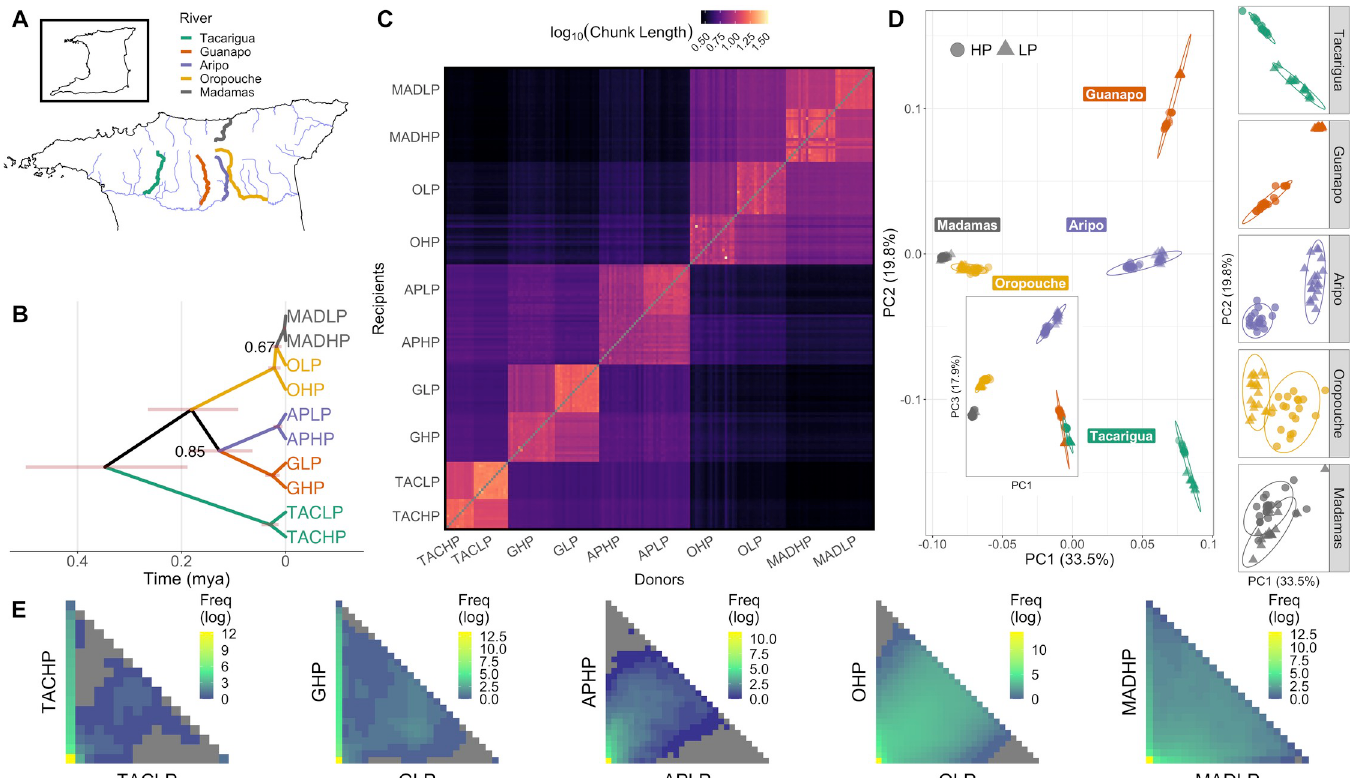
Fig 1. Sampling sites, population structure and admixture across the five rivers. Map (A) highlights sampled rivers from the three drainages in Northern Trinidad. Other major rivers are illustrated in light blue. Sampling rivers plotted alongside topography is available in S3 Fig. The coastline shapefile was sourced from OpenStreetMap (openstreetmap.org; CC BY-SA 2.0), rivers were added manually and are available as shapefiles at Zenodo doi: 10.5281/zenodo.4740381. The dated phylogeny (B) of sampling populations based on SNAPP, highlighting sister statuses of each HP-LP pair. Red regions around nodes denote 95% uncertainty around dates. Nodes with < 90% support are indicated with their posterior support. Heatmap (C) illustrates the length of painted recipient haplotypes based on donor haplotypes, used by fineSTRUCTURE to infer coancestry (values are log10-transformed). PCA (D) with populations coloured according to river and shaped according to predation regime. PC1 and PC3 are presented in the insert. In the main panel, ellipses denote river clusters at 95% confidence intervals. The right-hand column shows zoomed-in regions around each river cluster on PC1 and PC2, with ellipses highlighting separation and 95% confidence intervals of predation clusters. Heat maps in (E) show projected two- dimensional site frequency spectra (2dsfs) for each river pair highlighting the sharing of variants between LP and HP populations within each river. LP populations are on the x-axis and HP populations are on the y-axis. In each sfs, the frequency of sites in each population is illustrated from 0 to 2 N, where N is the number of individuals in each population. Each cell within these 2dsfs therefore shows the density (log-transformed) of SNPs with relevant allele counts in each population. Cells within the first column and first row show private alleles that are absent in one population (allele count of 0). Grey cells are missing data, where no SNPs are found at allele counts of x and y in LP and HP populations